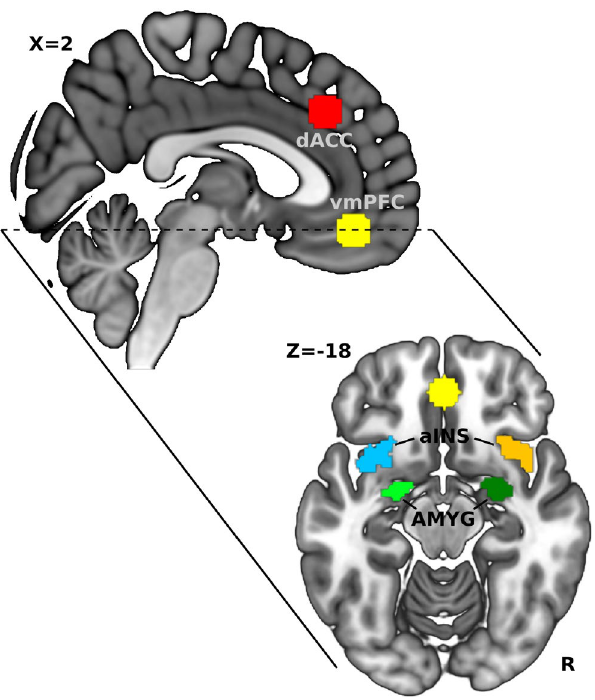
Figure 4. Locations of ROIs used for seed-based rsFC analysis. dACC—dorsal anterior cingulate cortex, vmPFC—ventrolateral prefrontal cortex, aINS—anterior insula,